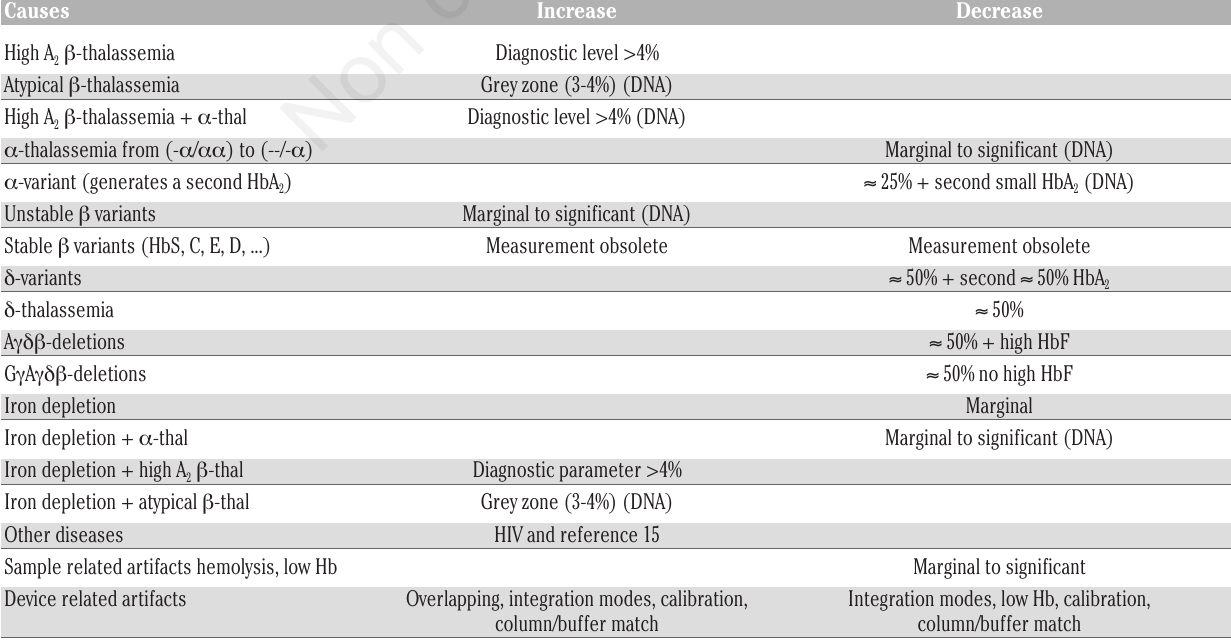
Table 1. Summary of common conditions increasing, decreasing or influencing hemoglobin A